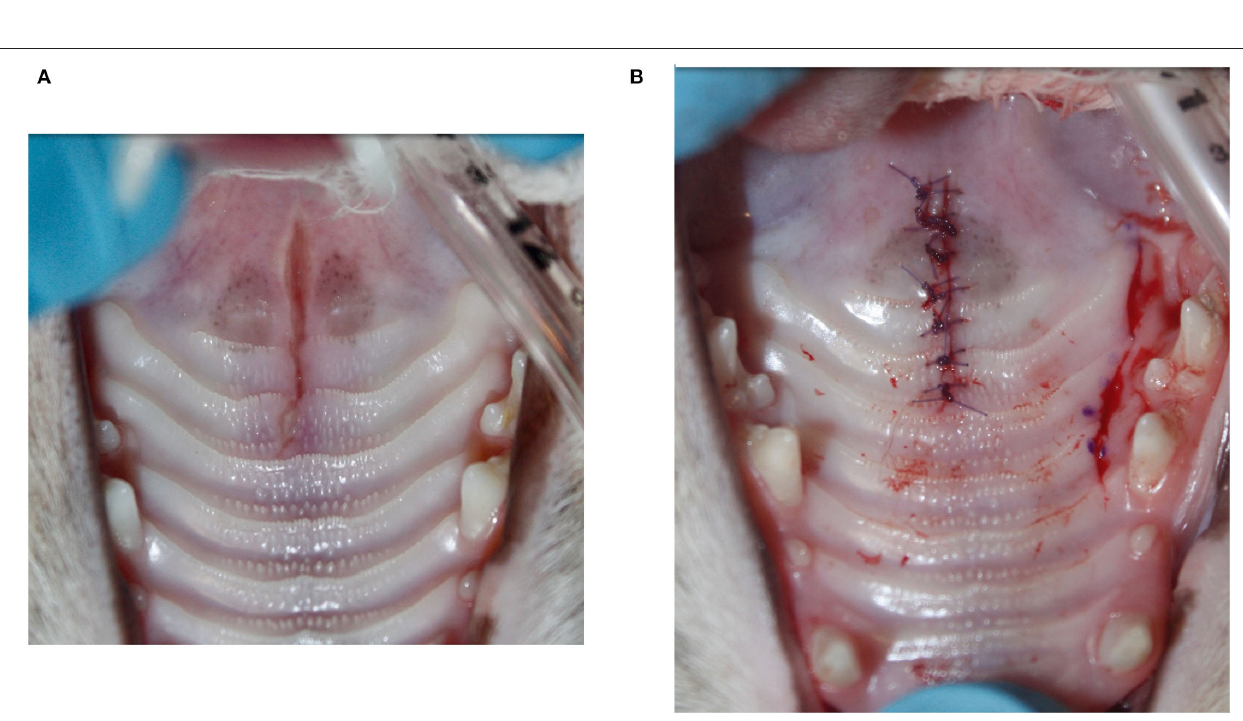
Frontiers in Veterinary Science |